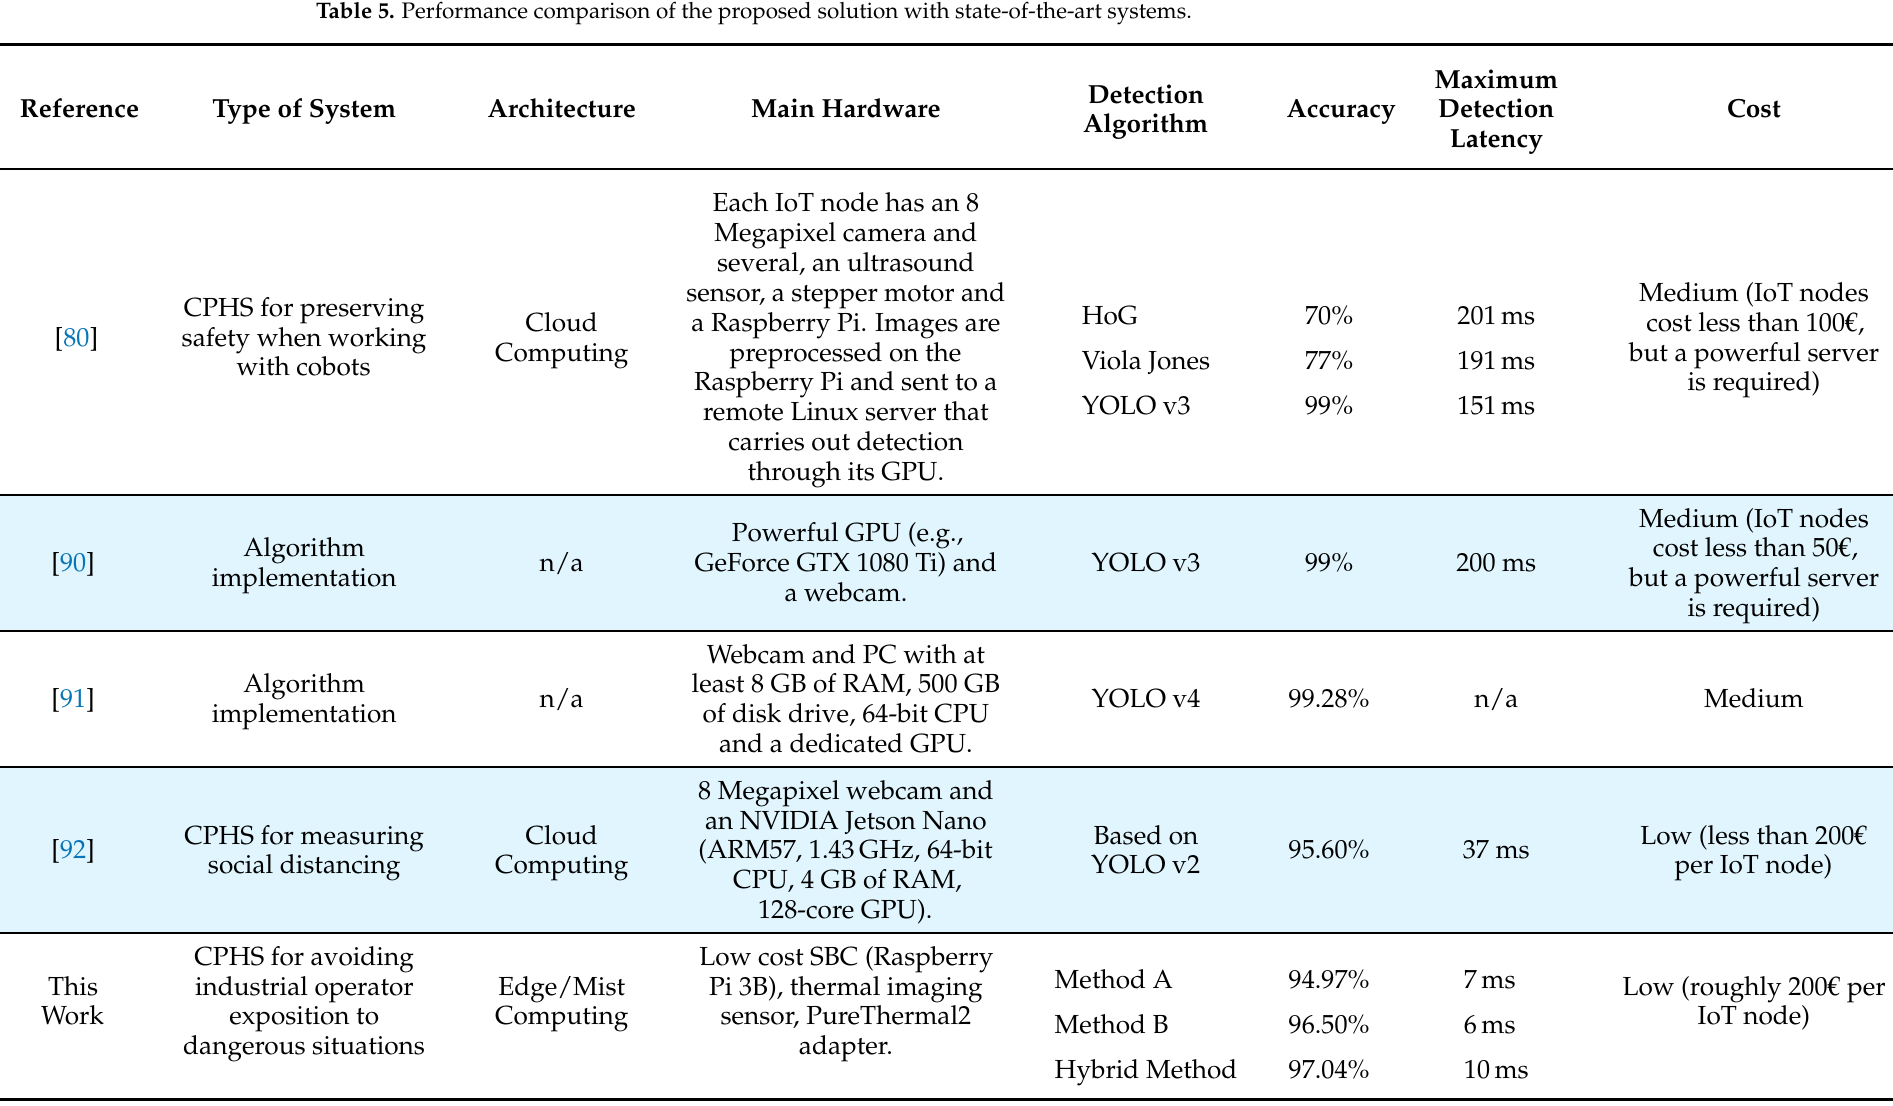
Table 5. Performance comparison of the proposed solution with state-of-the-art